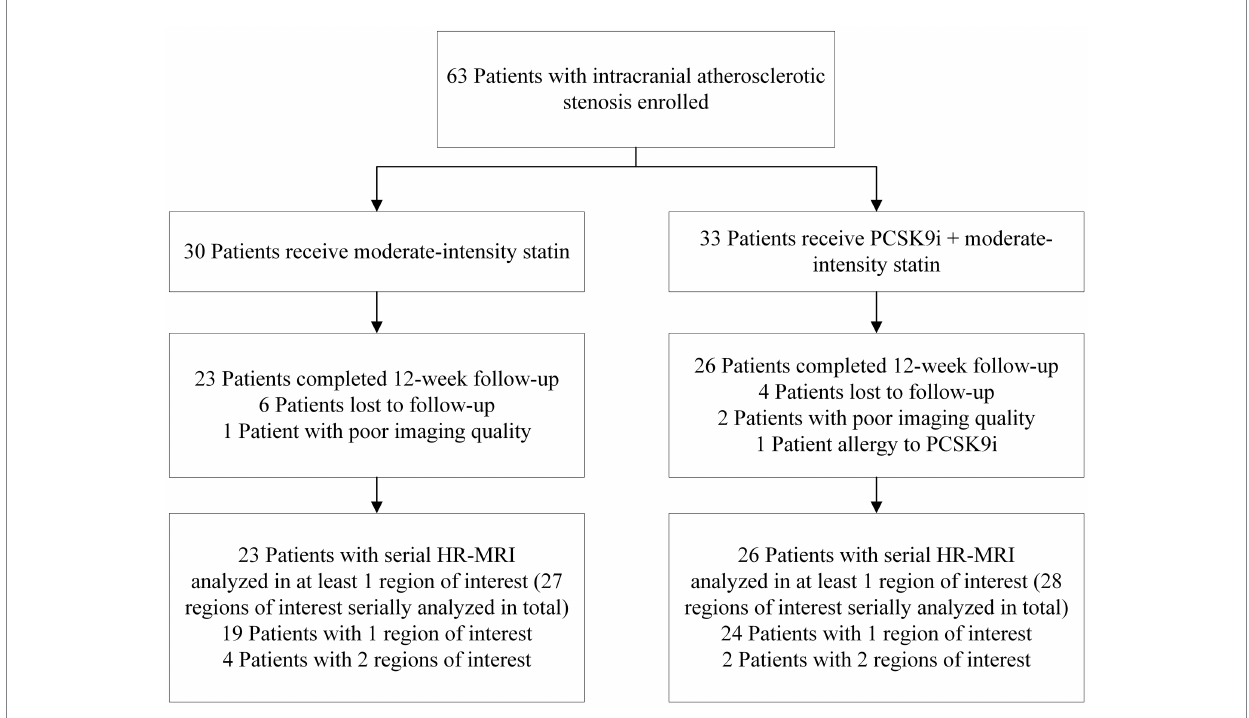
FIGURE 2 Cohort selection decision tree. PCSK9i, a proprotein convertase subtilisin/kexin type 9 inhibitor; HR-MRI, high-resolution